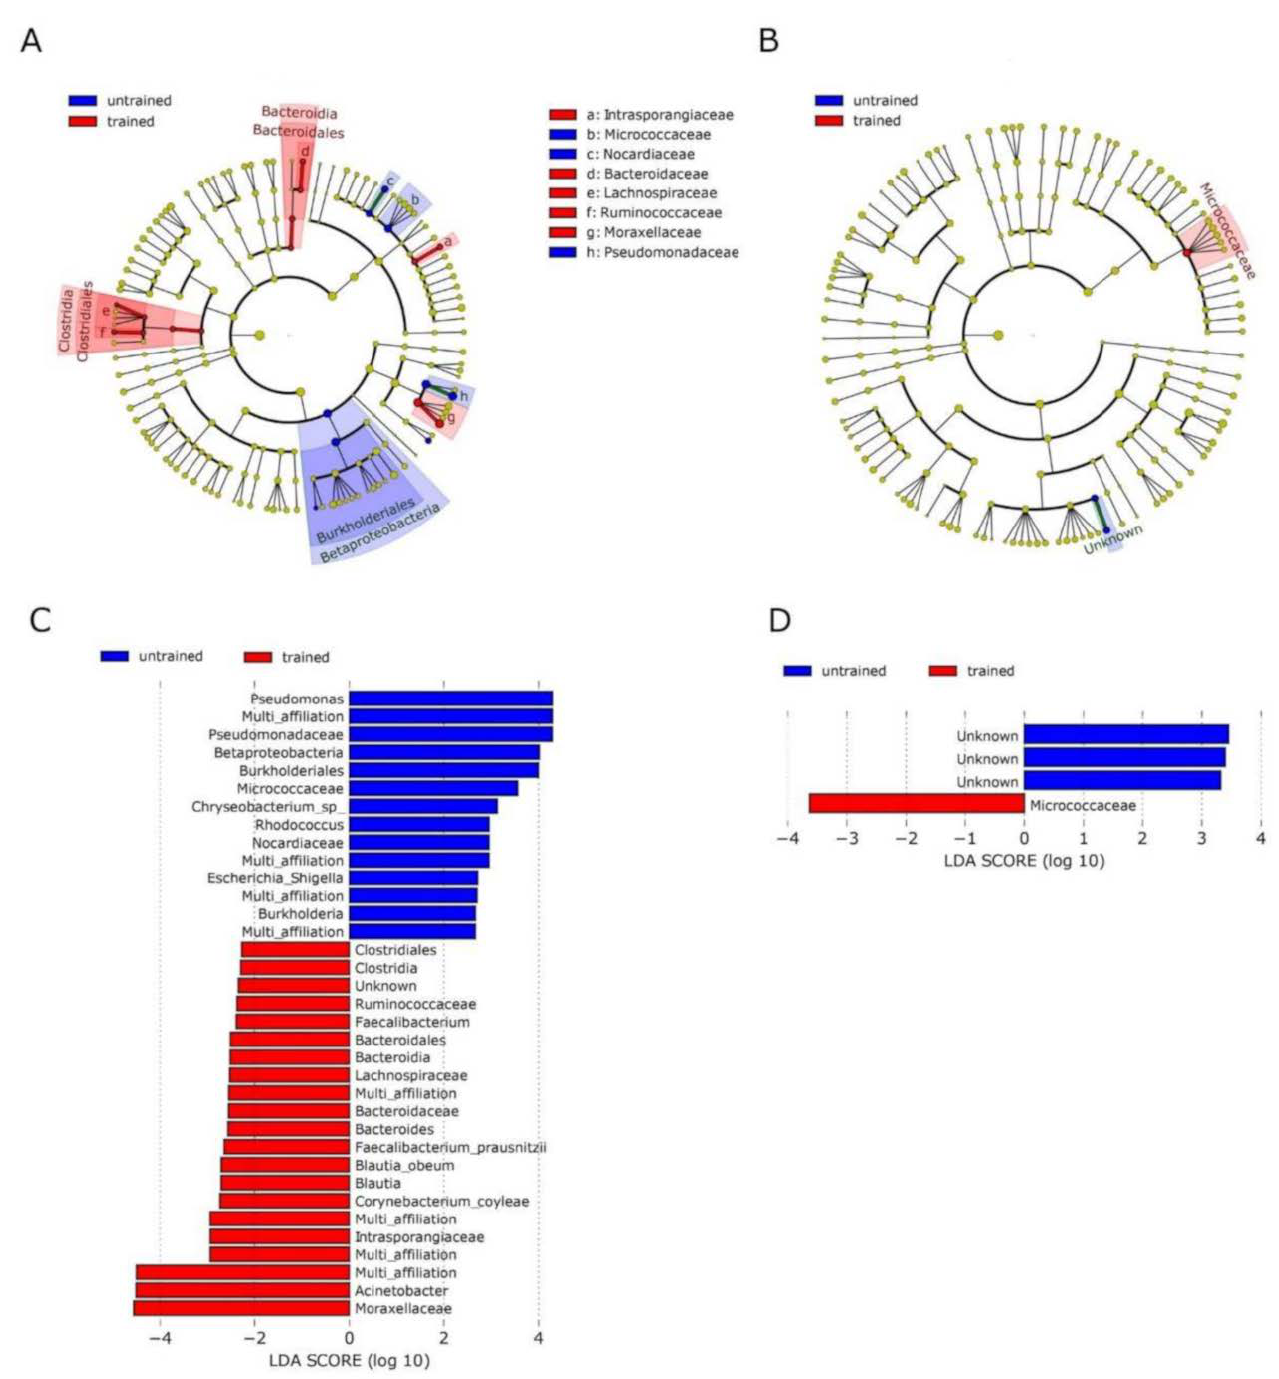
Figure 4. Analysis of taxonomic differences after training in blood and muscle: Linear discriminant analysis effect size (LEfSe) was used to identify taxonomic differences in the microbiota of skeletal muscle ( A , C ) and blood ( B , D ) before and after exercise training. Cladograms A and B give a representation of relevant OTUs on the taxonomic tree. C and D show ranked differential OTUs by effect size. The input file for the LEfSe analysis was obtained from the ‘phyloseq’ object using the LEfSe function of yungtools2 package. The LEfSe docker container (https://hub.docker.com/r/bioba kery/lefse (accessed on 19 February 2021)) was used to perform LEfSe analysis and figure